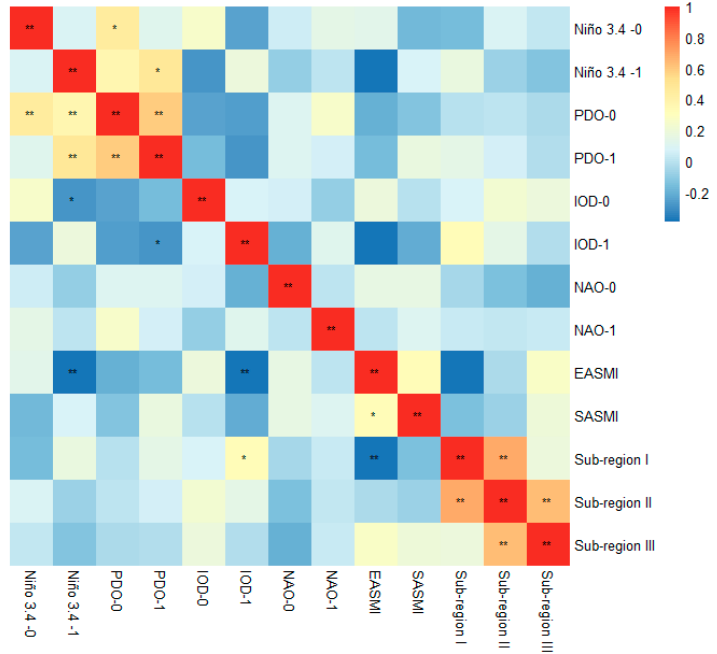
Figure 8. Correlation coefficients between climate indices and summer precipitation in sub-regions of the PYLB. The signs ** and * represent significant correlation coefficients at the 0.01 and 0.05 level, respectively.